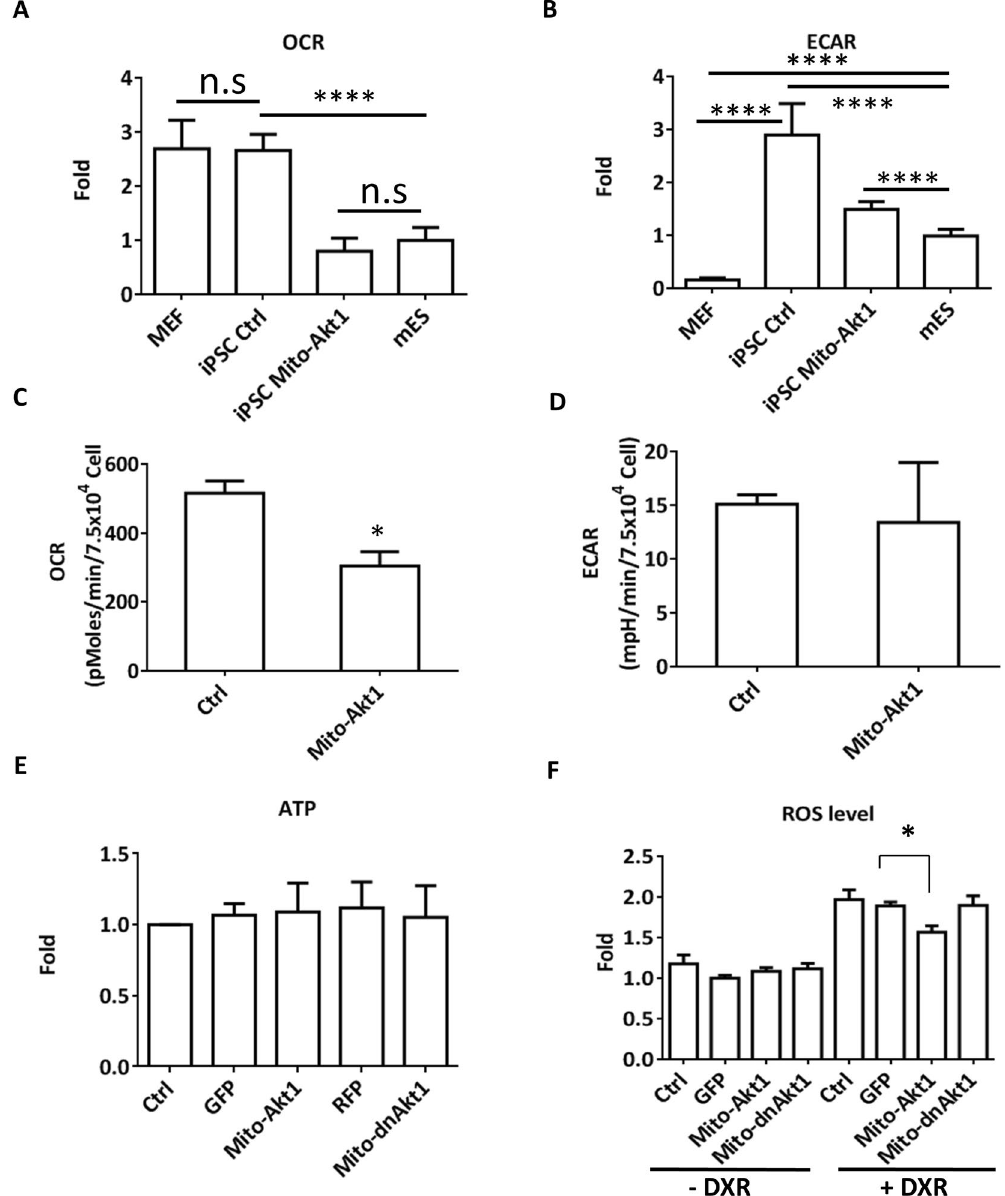
Figure 7. Mitochondrial Akt1 modulated cellular respiration. iPSCs at passage 10 were used for these studies. ( A ) Basal oxygen consumption rate (OCR) in MEF, mESC, and iPSC. ( B ) Basal extracellular acidification rate (ECAR) in MEF, mESC, and iPSC. ( C ) The effect of mitochondrial Akt1 activation on OCR. MEFs were transduced with Ad-Mito-Akt1 (Mito-Akt1) or Ad-GFP (control). 72 hours after transduction, the cells were analyzed with a Seahorse XF24 analyzer. Bar graph represents the results summarized from 3 independent experiments in triplicates. * p < 0.005 ( D ) The effect of mitochondrial Akt1 activation on ECAR in MEF. The cells were transduced with Ad-Mito-Akt1 (Mito-Akt1) or Ad-GFP (control). 72 hours after transduction, cells were studied with a Seahorse XF24 analyzer. ( E ) Cellular ATP contents in MEF. ATP level was quantified by mass spectrometry. ( F ) The effect of Mito-Akt1 on oxidative stress in MEF. Mitochondrial ROS was analyzed with MitoSOX Red and quantified by flow cytometry. Bar graph represents the results summarized from 3 independent experiments in triplicates. * p < 0.005. DXR: Stress induction with